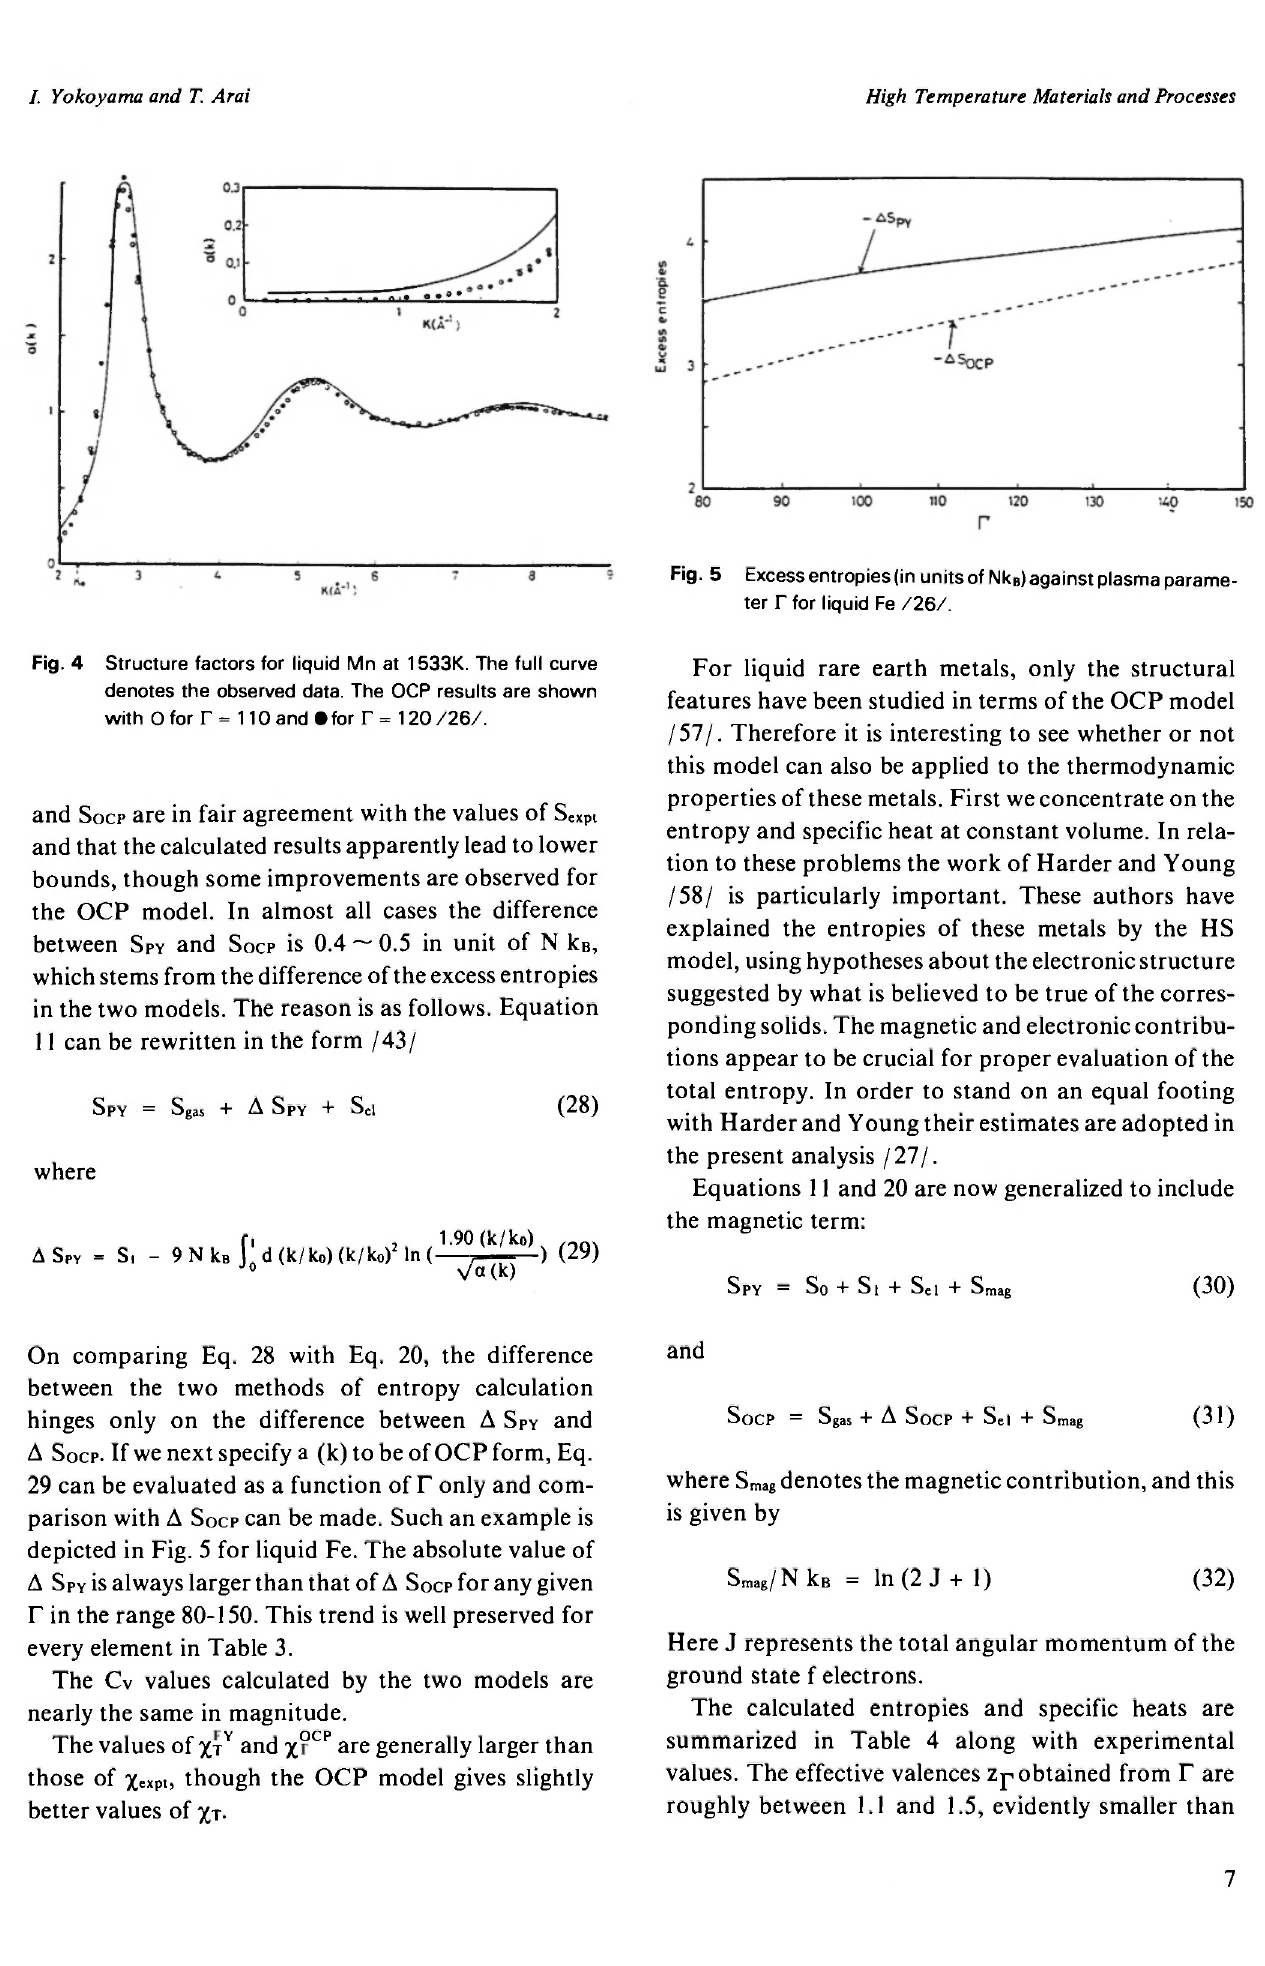
Fig. 4 Structure factors for liquid Mn at 1533K. The full curve denotes the observed data. The OOP results are shown with Ο for Γ = 110 a n d· for Γ = 120/26/.